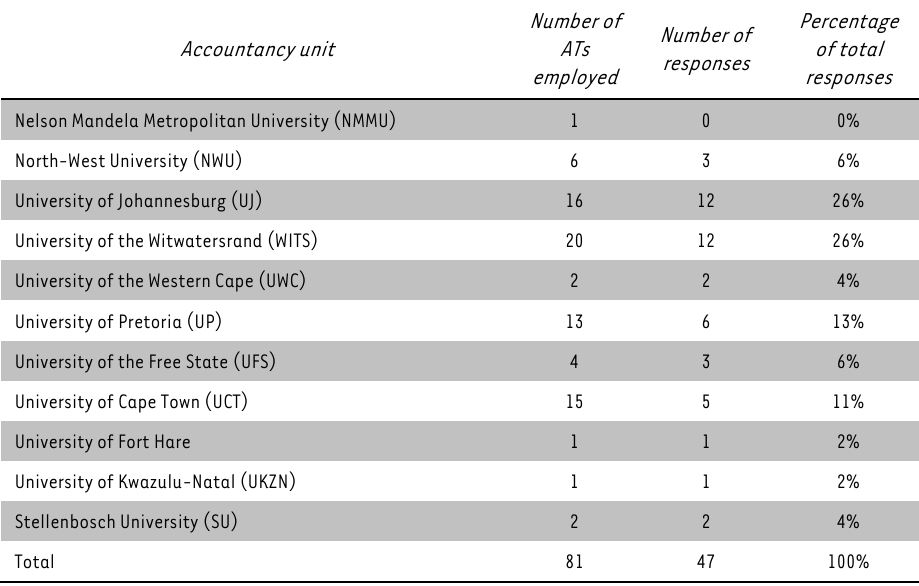
Percentage Number of Number of of total ATs responses responses employed